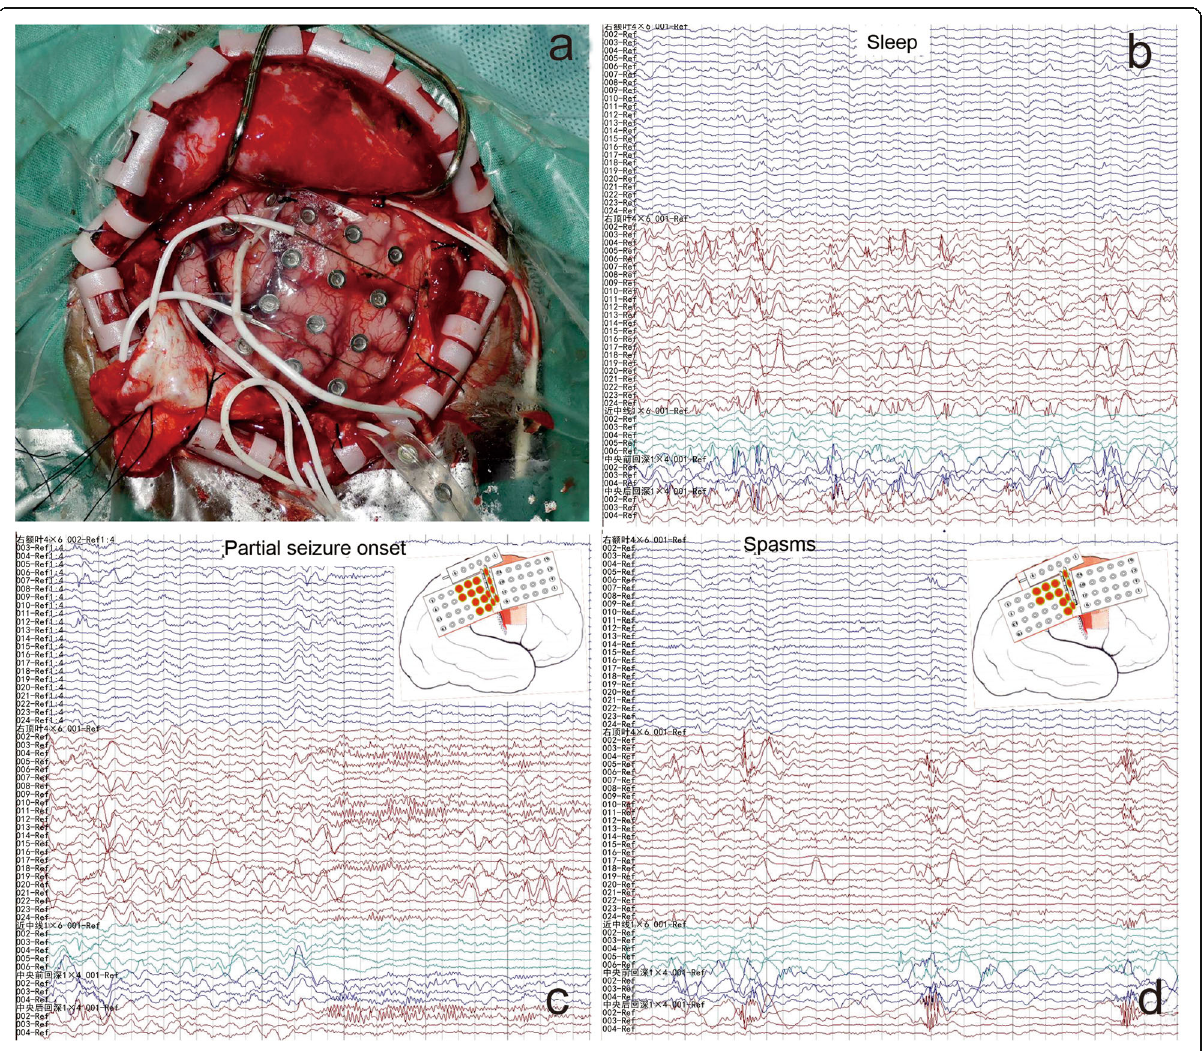
Fig. 4 Intracranial EEG for patient 2 with focal seizures and epileptic spasms. a Intraoperative electrode positioning. b A large number of focal abnormal discharges in the right parietal lobe and central area during the interictal period. c Focal seizures starting at the right central and midline area. d Spasm